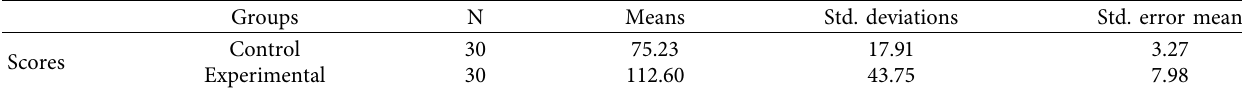
Table 3: Descriptive statistics of the experimental and control groups in the anxiety posttests.